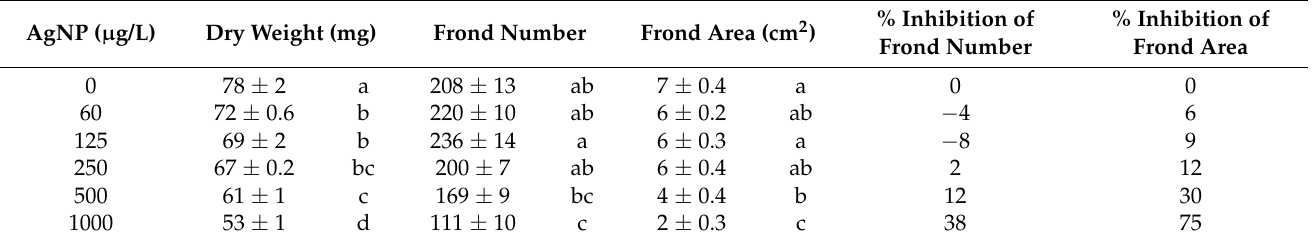
Table 4. Mean ± standard error for Experiment 2 dry weight, frond number, frond area, and percent inhibition (frond number and area) of Lemna minor after 14 days in different silver nanoparticle (AgNP)